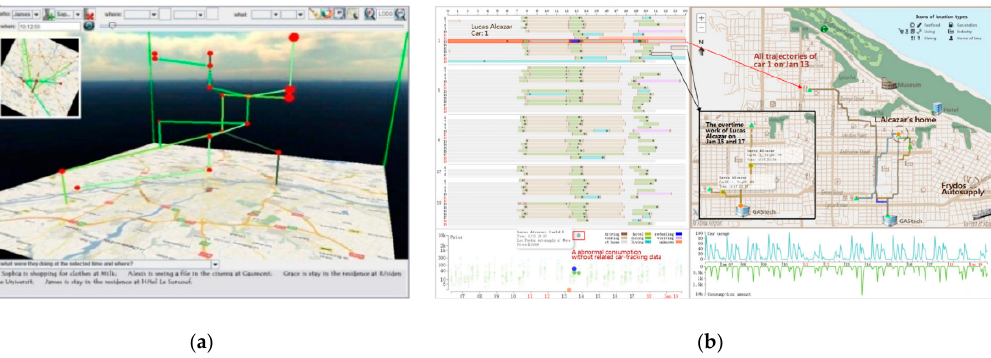
Figure 4. Examples of trajectory semantic visualization: ( a ) trajectory semantic-query system [7]; and ( b ) abnormal transactions and overtime work patterns of a criminal suspect [10].